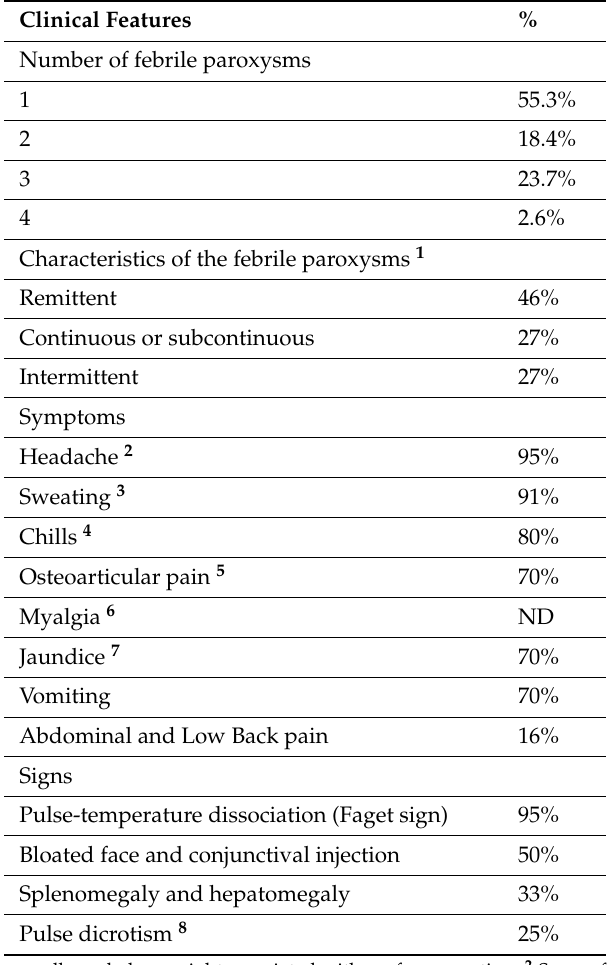
Table 1. Clinical features of 38 patients diagnosed with Tick-Borne Relapsing Fever (TBRF) in the department of Chocó, Colombia, 1923–1926